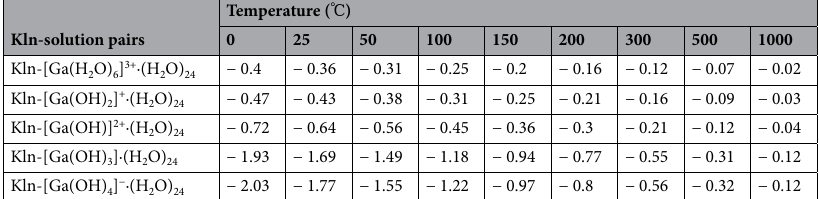
Table 3. The calculated 1000*ln(α) values ( 71 Ga/ 69 Ga) for pairs of Kln-[Ga(H 2 O) 6 ] 3+ ·(H 2 O) 24 , Kln-